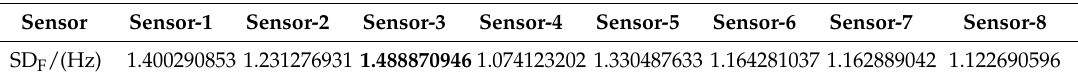
Table 4. Standard deviations of resonance frequency values on each sensor in realistic scenario.